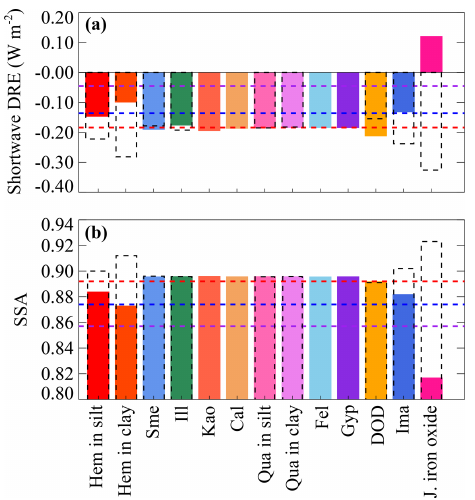
Figure 8. Global mean shortwave DRE by dust (a) and SSA at the 0.44–0.63µm band (b) averaged over pixels where DOD > 0.5 · AOD following Scanza et al. (2015) in CAM5 for dif- ferent cases in C1999 (the first 12 bars from the left) and J2014 (the last bar from the right). Values associated with parameters other than iron oxides, the imaginary complex refractive index, and DOD were derived from the “normalized” cases (see Sect. 2.3.1). Red dash lines indicate values obtained from the baseline simulation; blue dash lines denote values obtained from the simulation with J2014 distinguishing hematite from goethite; purple dash lines are similar to blue ones but with identical optical properties between hematite and goethite. Bars: values associated with higher (in color) and lower bounds (dash with opposite signs to real values) of min- erals, DOD, and imaginary complex refractive index. x -axis labels: Hem – hematite; Sme – smectite; Ill – illite; Kao – kaolinite; Cal – calcite; Qua – quartz; Fel – feldspar; Gyp – gypsum; DOD – dust aerosol optical depth; Ima – imaginary; J. iron oxide – iron oxides in